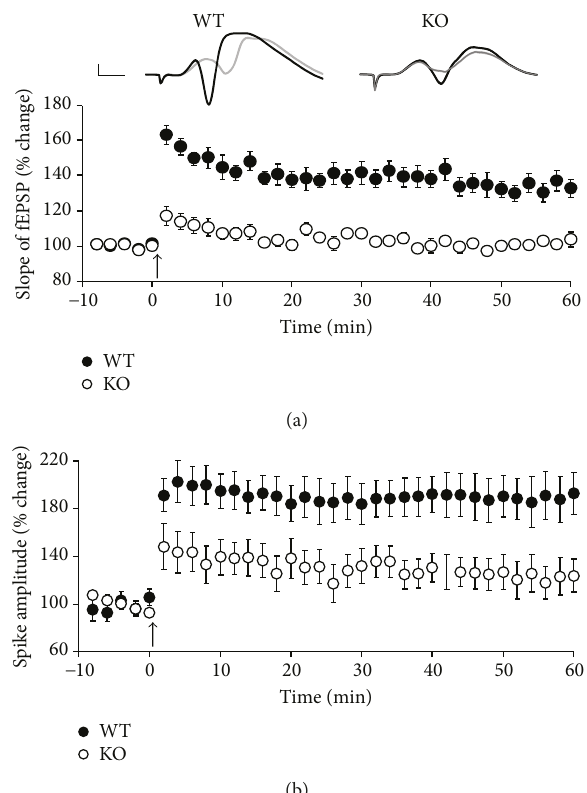
Figure 5: Reduced LTP in the dentate gyrus of collybistin (Cb) KO mice as compared to WT littermates. Mean fEPSP slope (a) and population spike (b) changes are plotted as a function of time. Arrows denote the start of the theta-burst stimulation protocol consisting of 6 series of 6 trains of 6 pulses at 400 Hz with 200 ms between trains and 20s between series. Top in (a): fEPSPs recorded before (grey) and after the induction of LTP (black). Calibration bars: 1 mV, 2ms (adapted with permission from